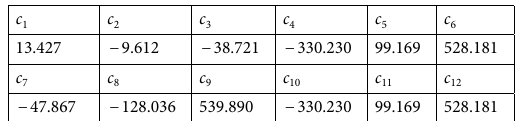
Table 3. Coefficient values for the P HbA 1 c . and P HbO equations of the blood-vessel model.